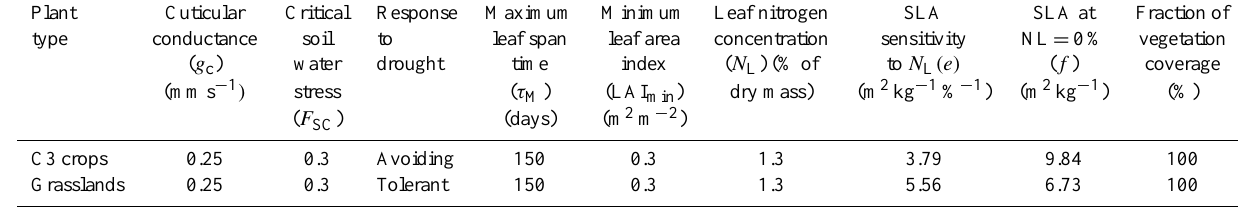
Table 1. Standard values of ISBA-A-gs parameters for C3 crops and grasslands (Gibelin et al., 2006). Plant